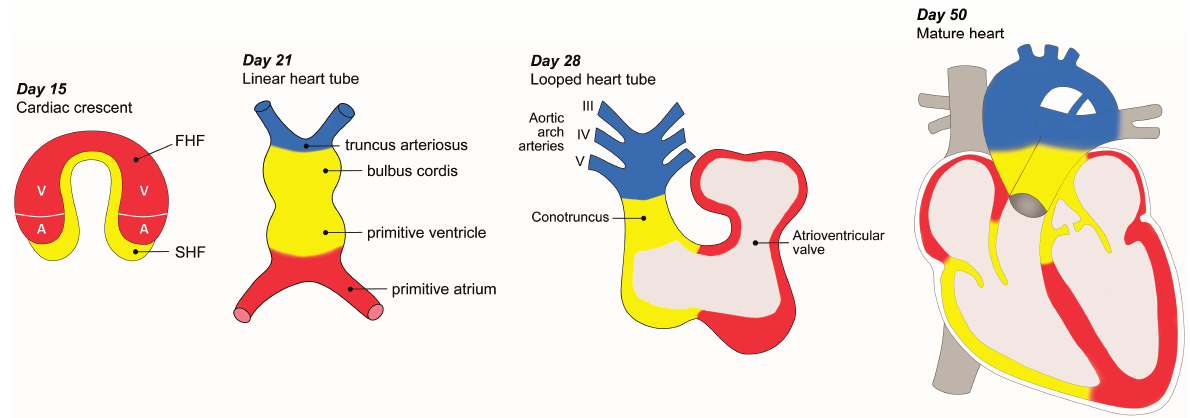
Figure 2. Stages of human cardiac development with color-coding of contributing cell populations, seen from a ventral view. These contributions are from the first heart field (red), second heart field (yellow) and cardiac neural crest (blue). By day 15 post-fertilization, the cardiac crescent is specified to form specific segments of the linear heart tube, which is patterned along the anteroposterior axis to form the looped and mature heart. Cardiac neural crest cells populate the aortic arch arteries (III, IV, and VI) and aortic sac (AS) that together contribute to specific segments of the mature aortic arch. Mesenchymal cells form the cardiac valves from the conotruncal (CT) and atrioventricular valve (AVV) segments. Abbreviations: A, atrium; V, ventricle; RV, right ventricle; LV, left ventricle; RA, right atrium; LA, left atrium; PA, pulmonary artery; Ao, aorta; DA, ductus arteriosus. Modified from